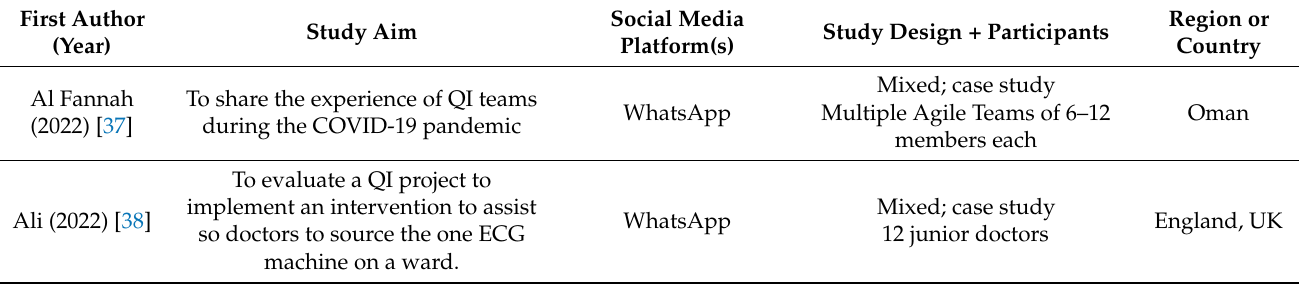
Table 2. Key characteristics of included